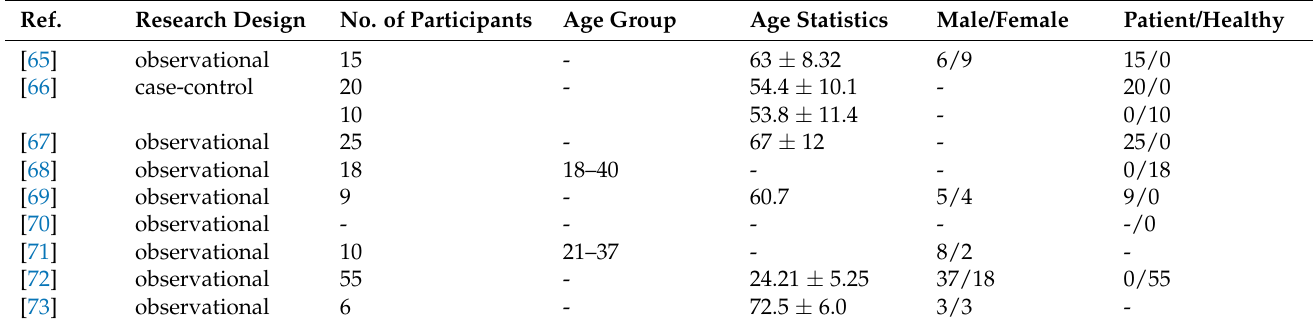
Table 7. Participant demographics for studies on rehabilitation. - = no information. Ref.